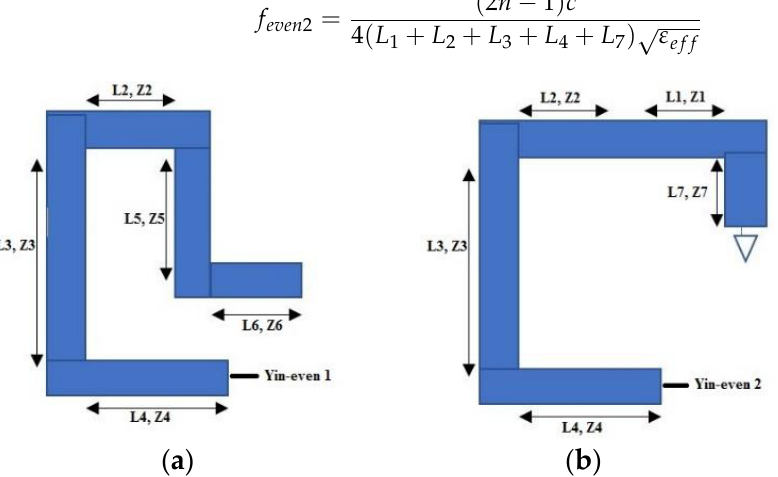
Figure 11. ( a ) First even-mode excitation circuit. ( b ) Second even-mode excitation circuit. To reduce the complexity of the mathematical calculation, assume Z 1 = Z 2 = Z 3 = Z 4 = Z 5 . Using the same basic microwave network theory discussed in the odd-mode case, i.e., Y in even 2 = 0 and Y in even 2 = 0.